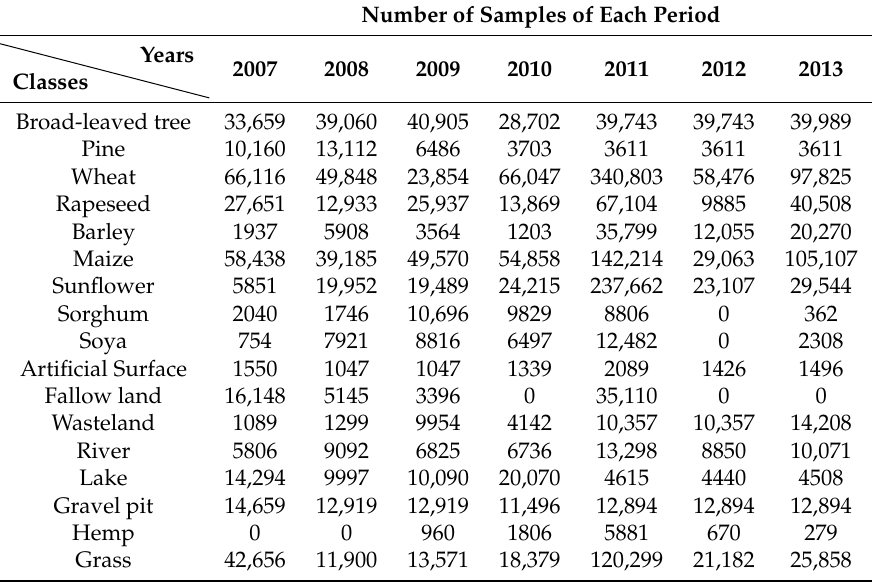
Table 1. Nomenclature and number of samples for each